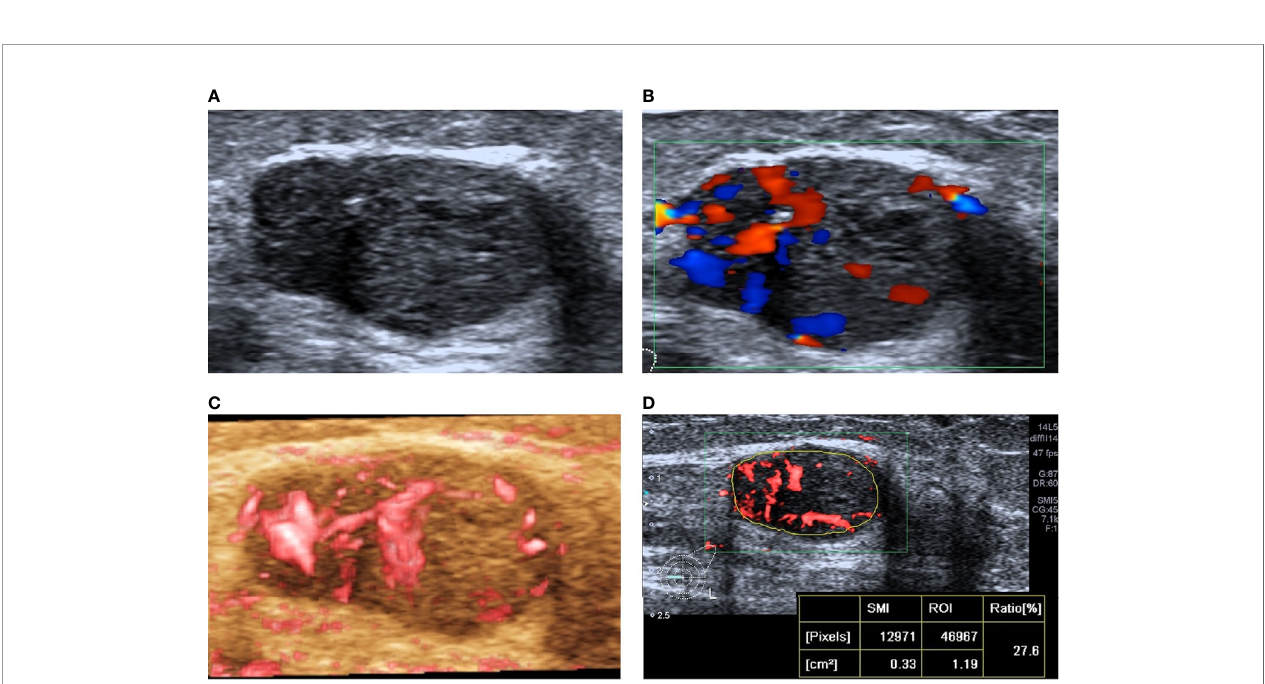
FIGURE 5 | A 31-year-old woman with invasive ductal carcinoma was upgraded from BI-RADS 4C to BI-RADS 5 after SMI assessment. (A) Two-dimensional ultrasonography shows an irregular hypoechoic lesion, and punctiform microcalci fi cation was observed. (B) CDFI shows abundant blood fl ow signals around and inside the lesion. (C) SMI shows a claw crab-like VA. (D) The vascular index was measured by delineating the lesion edge on the plane with the most abundant blood vessels, and the value was 27.6.